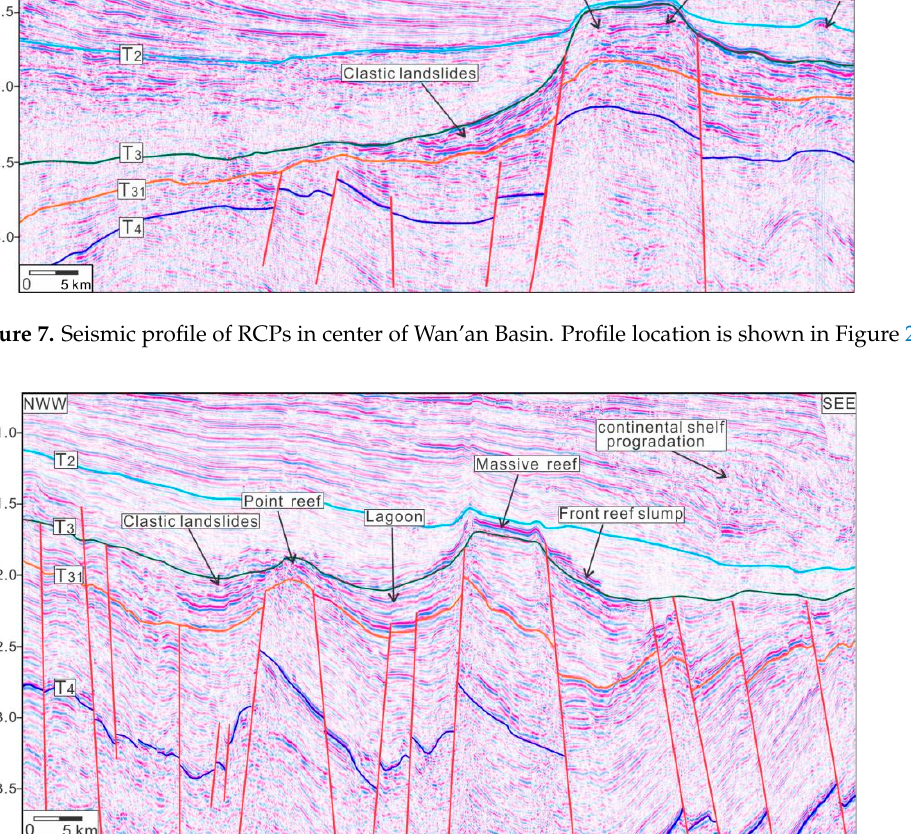
Figure 8. Seismic profile of RCPs in center and south of Wan’an Basin. Profile location is shown in Figure 2c.